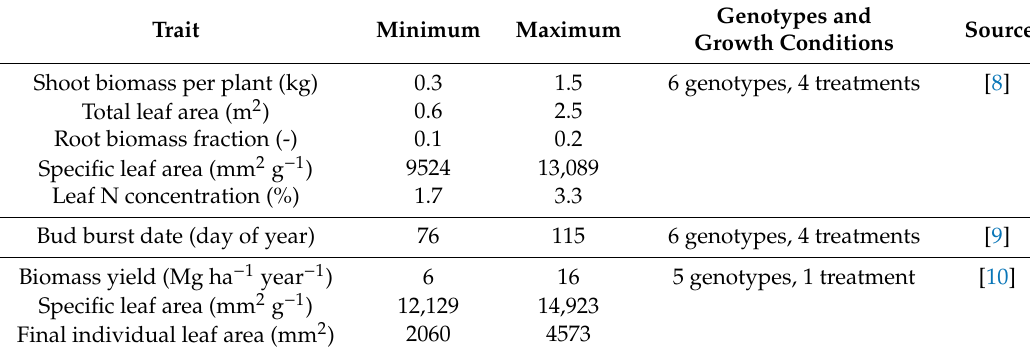
Table 1. Ranges of functional trait values observed in similar-aged willow genotypes field-grown in SRC systems in Sweden and UK; the smallest (Minimum) and highest (Maximum) values observed in any of the genotypes grown in the respective trial are